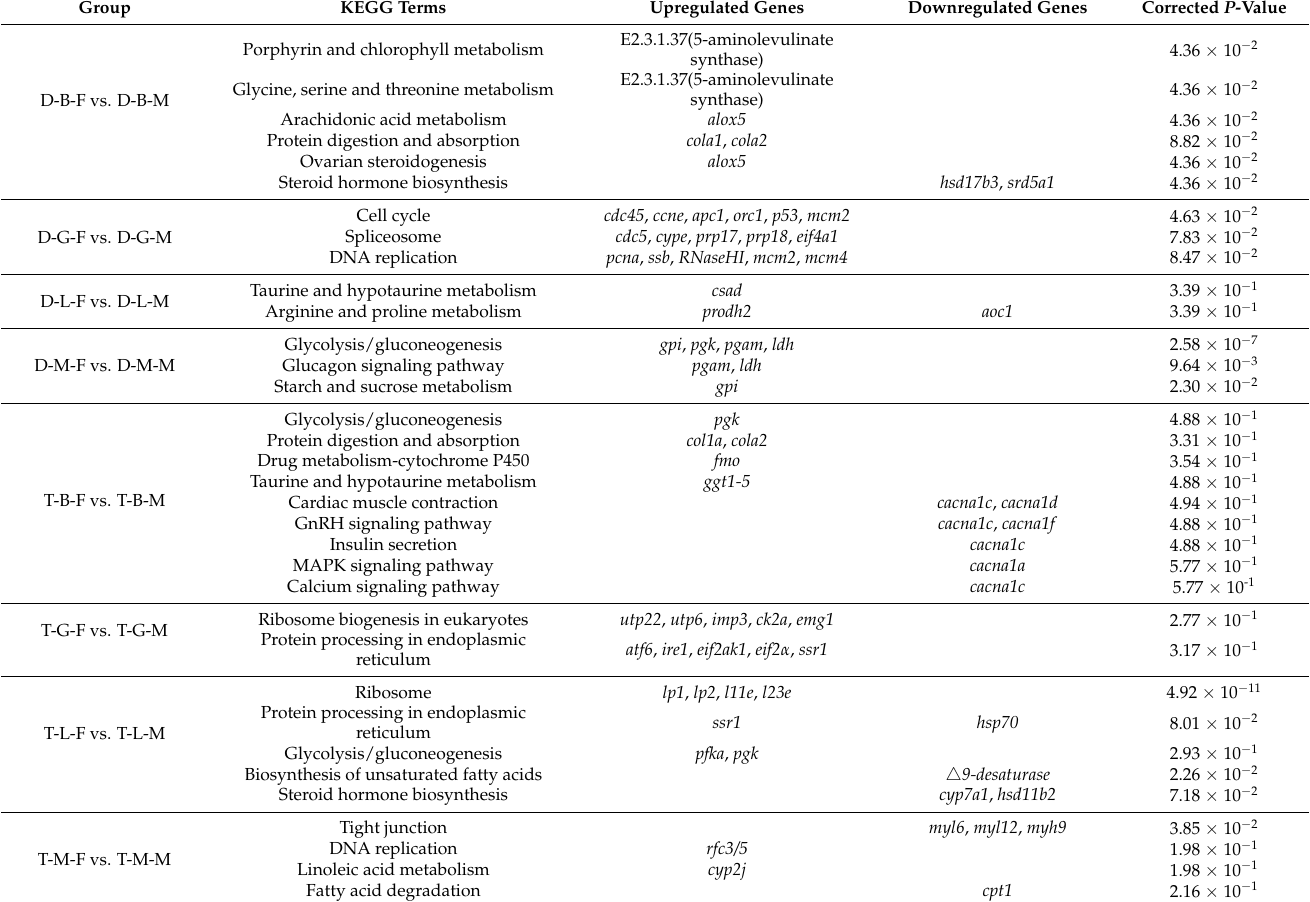
Table 1. Growth-related KEGG pathways in each comparison